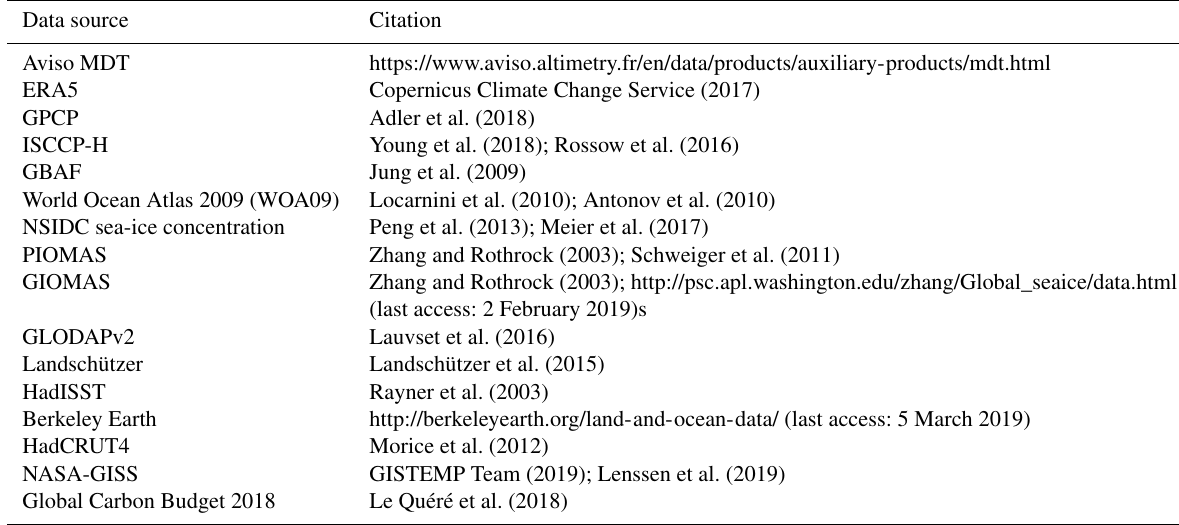
Table F2. List of observational products used.